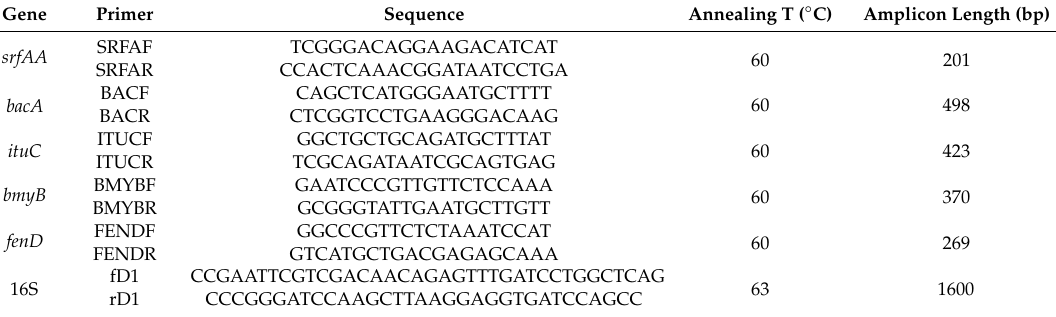
Table 1. List of the oligonucleotides used in this study to detect antibiotic genes by PCR screening and to amplify the 16S rDNA gene in the genomes of the selected antagonists. Annealing temperature and lengths of the amplicons are